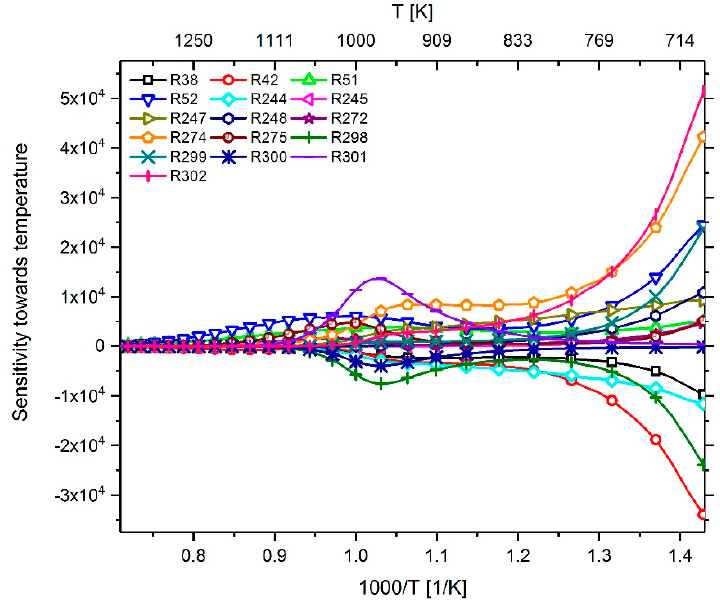
Figure 8. Reaction sensitivity towards temperature simulated with mix 9 from Table 1.